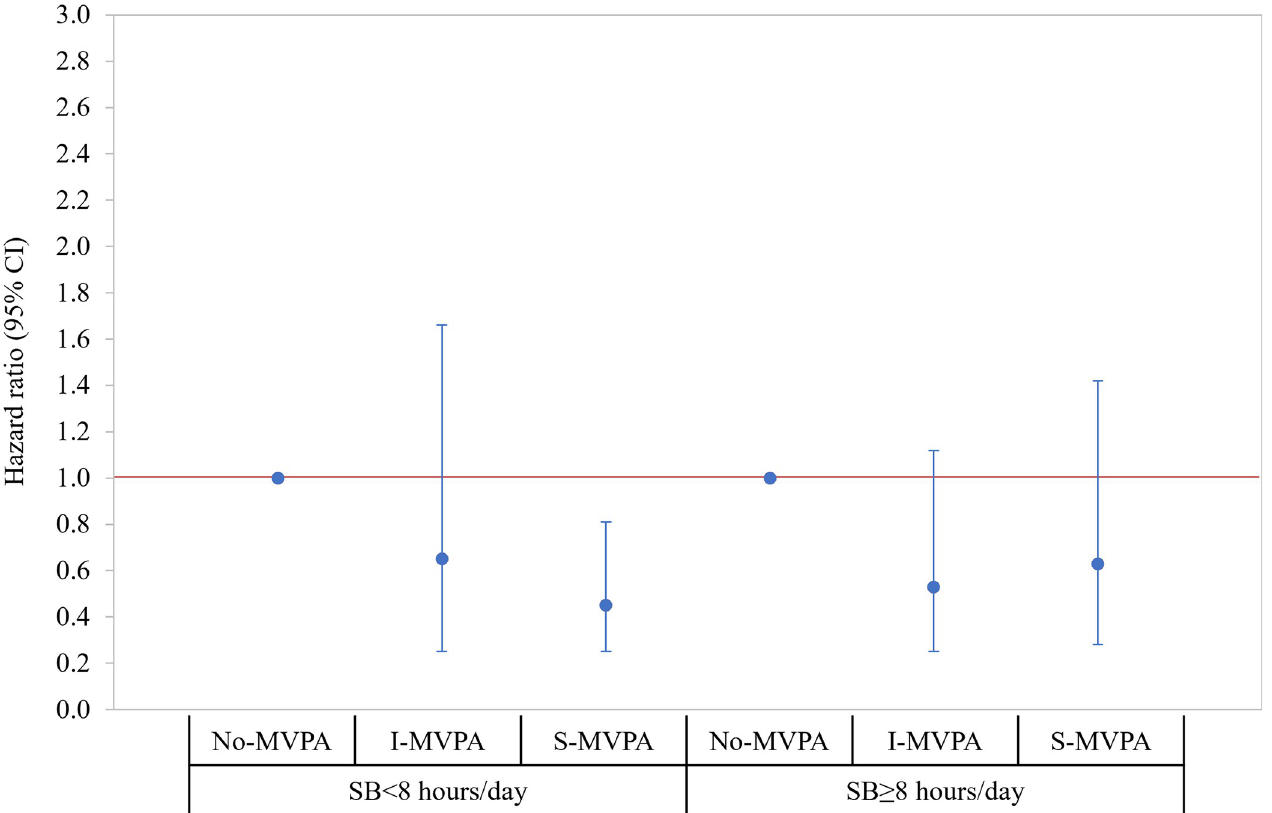
Fig 2. Stratified associations by SB level where HF patients with inactive (no-MVPA) were a reference group within each stratum. Hazard ratios (95% CI) were estimated from the Cox proportional hazard regression model adjusting the study covariates retained using the backward elimination approach ( P < .20), as described in Fig 1 . The estimated parameters presented in the figures are reported in Online Supplemental Table 5 in S1 File . CI = confidence interval; SB = sedentary behavior; I-MVPA = insufficient moderate-vigorous-intensity physical activity (MVPA minute/week between 0 and 150); S-MVPA = sufficient moderate- and vigorous-intensity physical activity ( � 150 minutes/week of